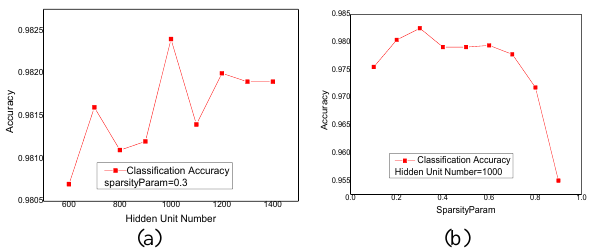
Figure 7 Parameter analysis for the hidden unit number and sparsity parameter with the Pavia University dataset.